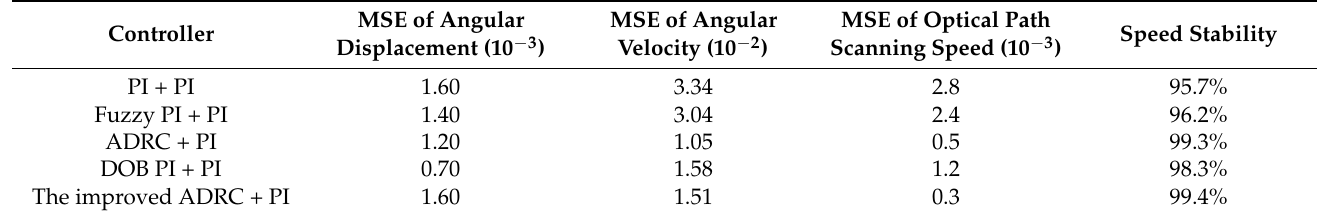
Table 4. The tracking performance of five